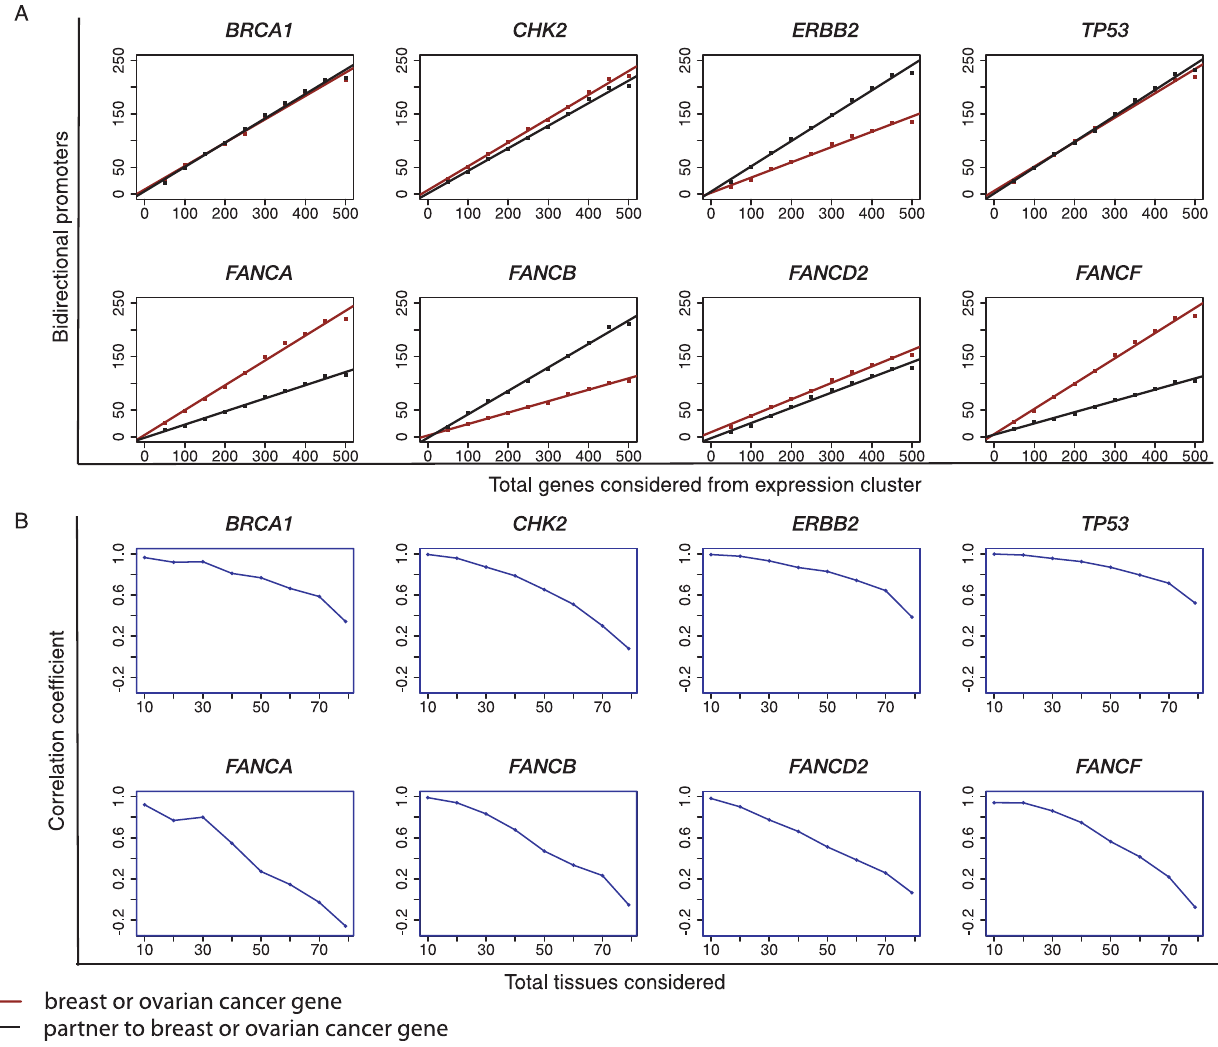
Figure 4. Co-Regulation of Bidirectional Promoters (A) The number of bidirectional promoters is graphed for the breast and ovarian cancer genes (solid brown line) and their bidirectional partner genes (solid black line). All graphs have the same axes: ( x ) the ranking of genes in the expression cluster according to their distance from the target gene and ( y ) the number of bidirectional promoters identified at this distance. (B) The correlation coefficient between each breast and ovarian cancer gene and its partner was calculated using the expression data in all 79 tissues. The correlation coefficients are plotted from the largest to smallest values; therefore, the tissue identity may change between plots to accommodate the ordering